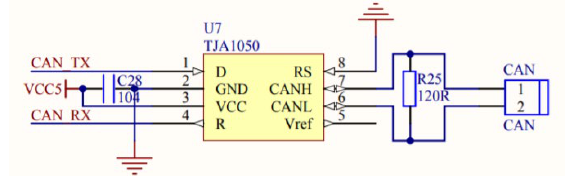
Figure 12. Schematic diagram of CAN bus transceiver circuit.